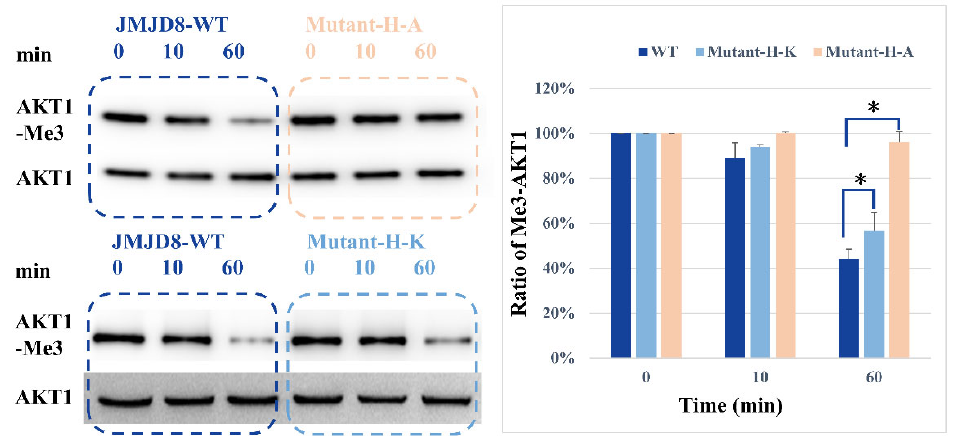
Figure 3. Western blotting analysis of demethylase activity toward full-length AKT1. Western blotting analysis was used to estimate the extent of demethylation of the full-length AKT1 protein by JMJD8 and its mutant (Mutant-2H-2K, Mutant-2H-2A) in vitro. The remaining trimethylated lysine was labeled by a specific antibody after the reaction of demethylation. The reaction was carried out for 0, 10 and 60 min with JMJD8, methylated AKT1 and cofactors mixing together. The right panel shows the relative ratio of remaining trimethylated-AKT1 protein analyzed by ImageJ software. Data were pooled from three independent experiments, and the results are represented as mean ± SD. * p < 0.05.